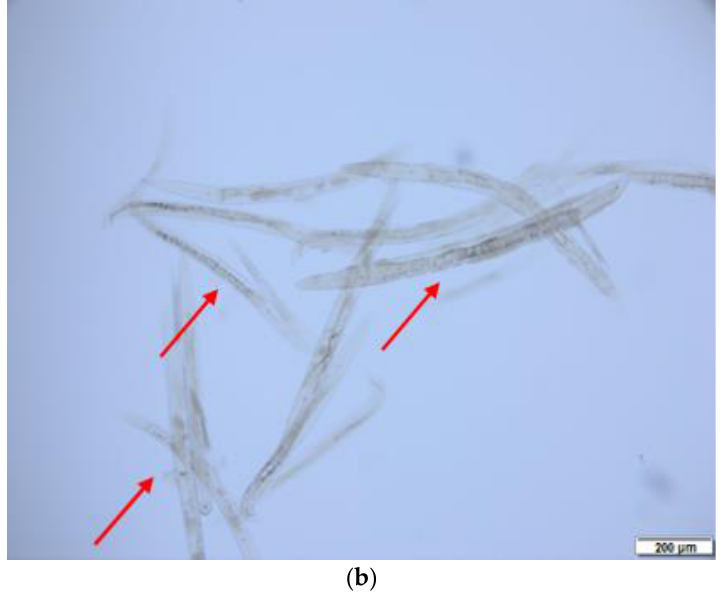
Figure 6. An exemplary nematode culture of Rhabditis sp. after 24 h exposure to compound 12 . ( a ) control (blue arrows — alive, mobile), ( b ) after treatment (red arrows — dead, non-mobiles).